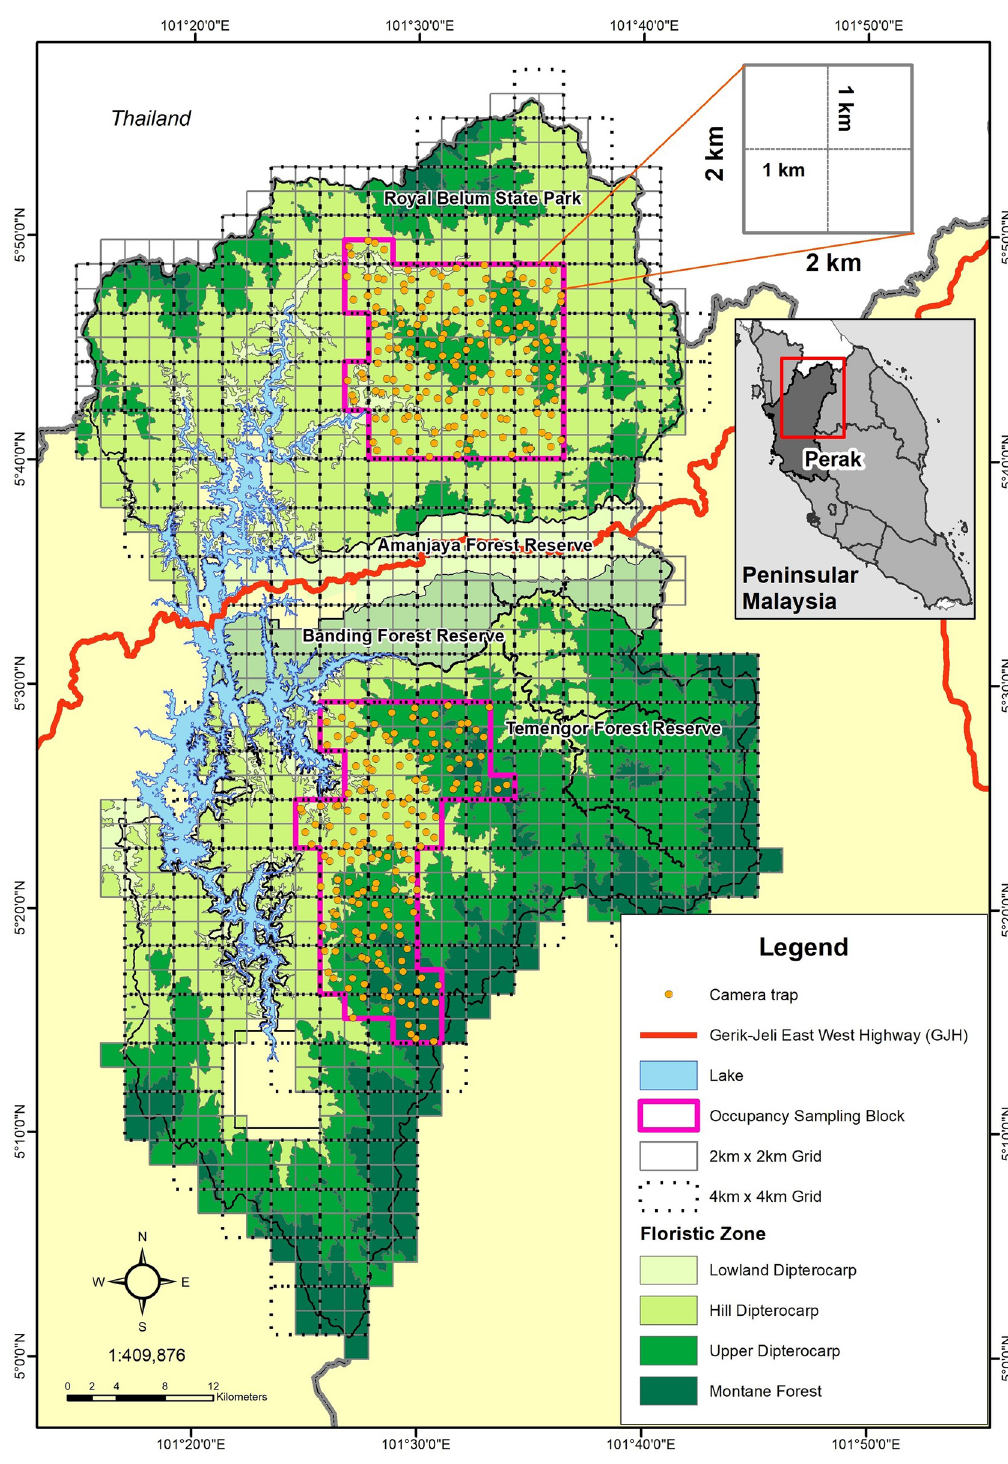
Fig 1. Location of the study areas of Temengor Forest Reserve and Royal Belum State Park, occupancy sampling block and camera traps.